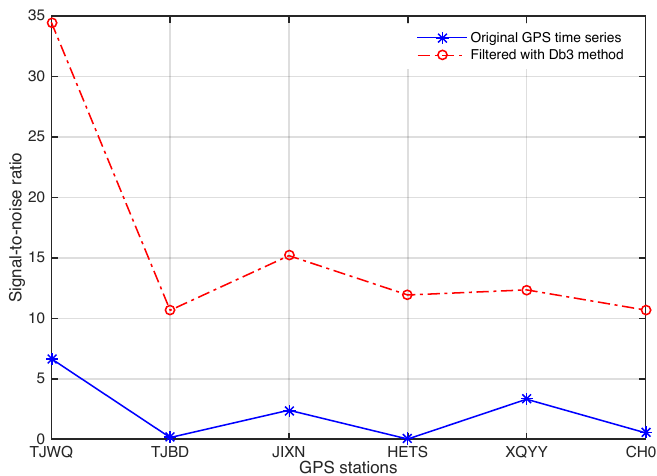
Figure 9. Signal-to-noise ratio of the original and filtered GPS time series. The blue line denotes the SNR of the original GPS time series and the red line denotes the SNR of the time series filtered with a Db3 wavelet.